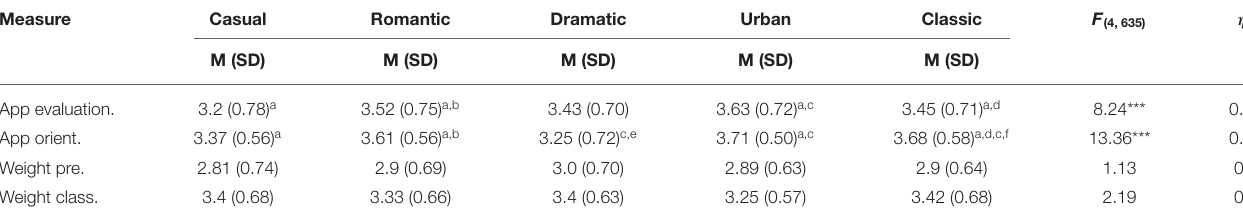
TABLE 4 | One-way ANOVA for testing body image dimensions and clothing styles ( N = 792). Measure Casual Romantic Dramatic Urban